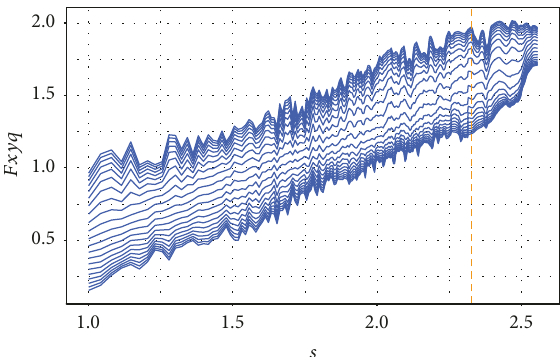
Figure 6: Log-log plots of 𝐹 𝑥𝑦𝑞 (𝑠) versus 𝑠 for amount of total news and the return of SSE